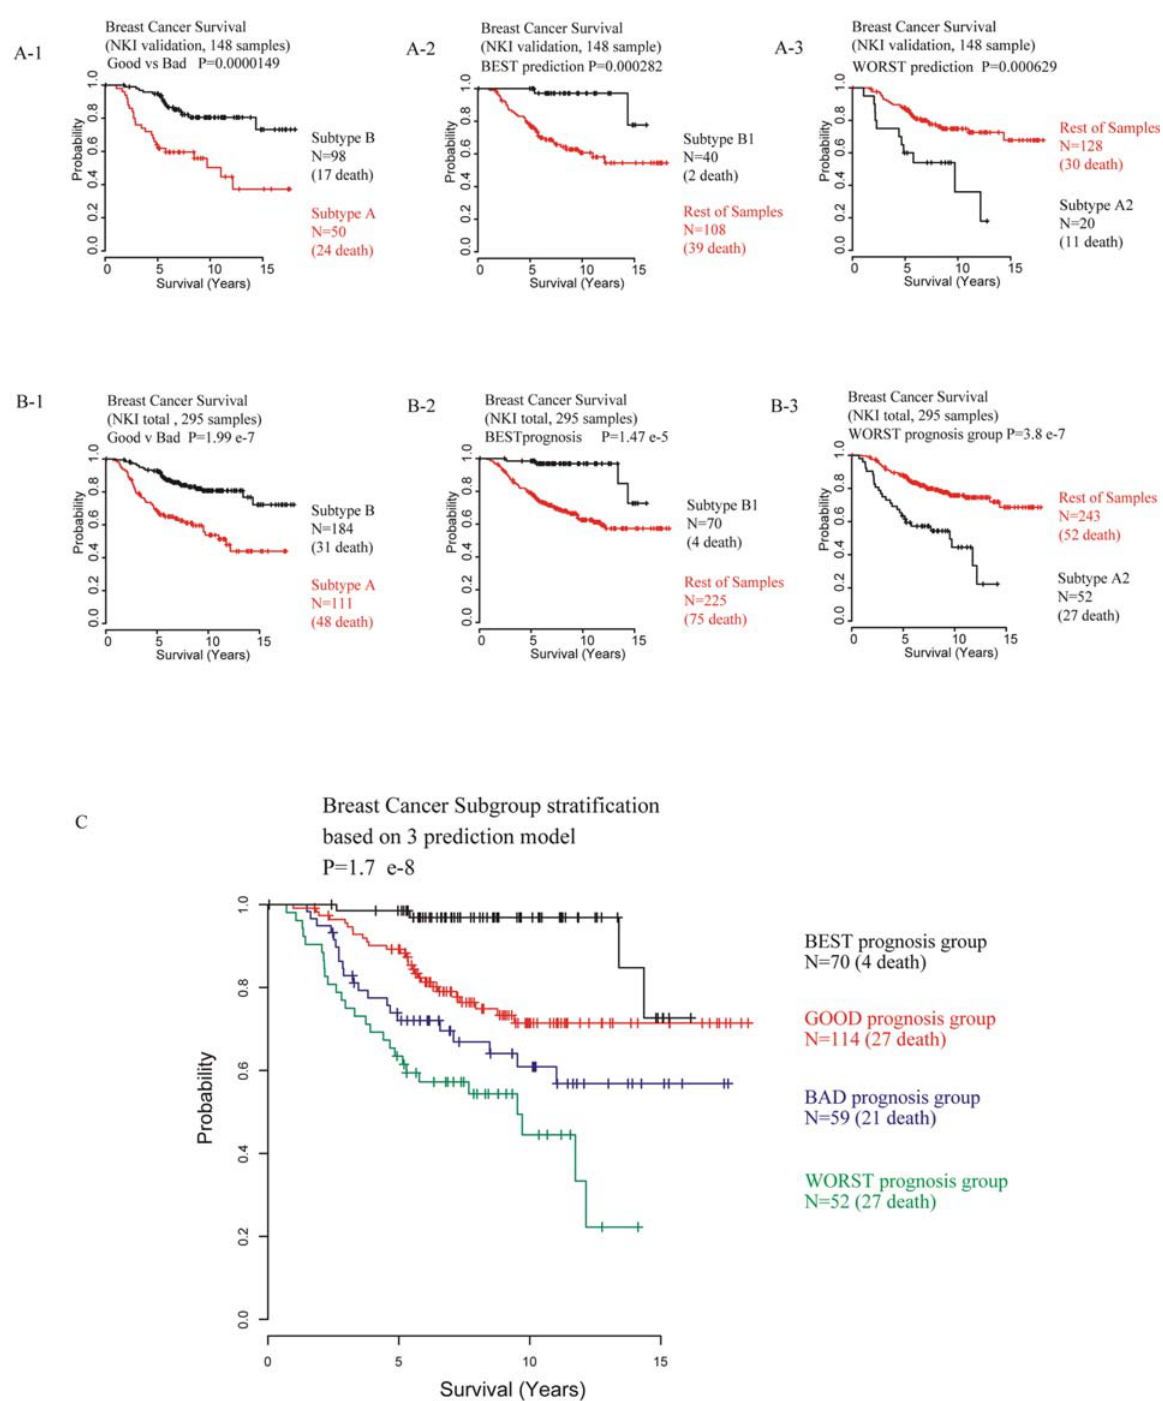
Figure 5. Defining four distinct survival subgroups of human breast cancer A. Predicted outcomes in NKI test set (148 patients). Kaplan-Meier plot for the representative groups for 6 different prediction algorithms. If a sample was predicted to belong to the test class (black lines) 3 or more times in the 6 different prediction methods, it was assigned to that group. Otherwise that patient/sample remained in ‘‘rest of all’’ (red lines). There were no 3:3 ties for predictor 1. For predictors 2 and 3, ties were assigned to BEST and WORST, respectively. B. Predicted outcomes for combined NKI data sets (295 total patients). Kaplan Meier plots of overall survival of two independent groups identified with two independent analyses (unsupervised clustering in training data set and class prediction in validation set). C. Kaplan-Meier plot of four independent prognostic subtypes generated with the NKI data set. Four independent prognostic subtypes (BEST, GOOD, BAD, and WORST) are assigned as follows. Samples that fell into the Group B (good prognosis group) with predictor 1 (Good vs. Bad) but not assigned to the BEST prognosis group with predictor 2 (BEST vs. all the rest) were assigned to an intermediate group designated GOOD. Similarly, samples that did not fall into Group B (i.e., those that belonged to Group A, the bad prognosis group) with predictor 1 (Good vs. Bad) but not assigned to the WORST prognosis group in predictor 3 (WORST vs. all the rest) were assigned to an intermediate group designated BAD.